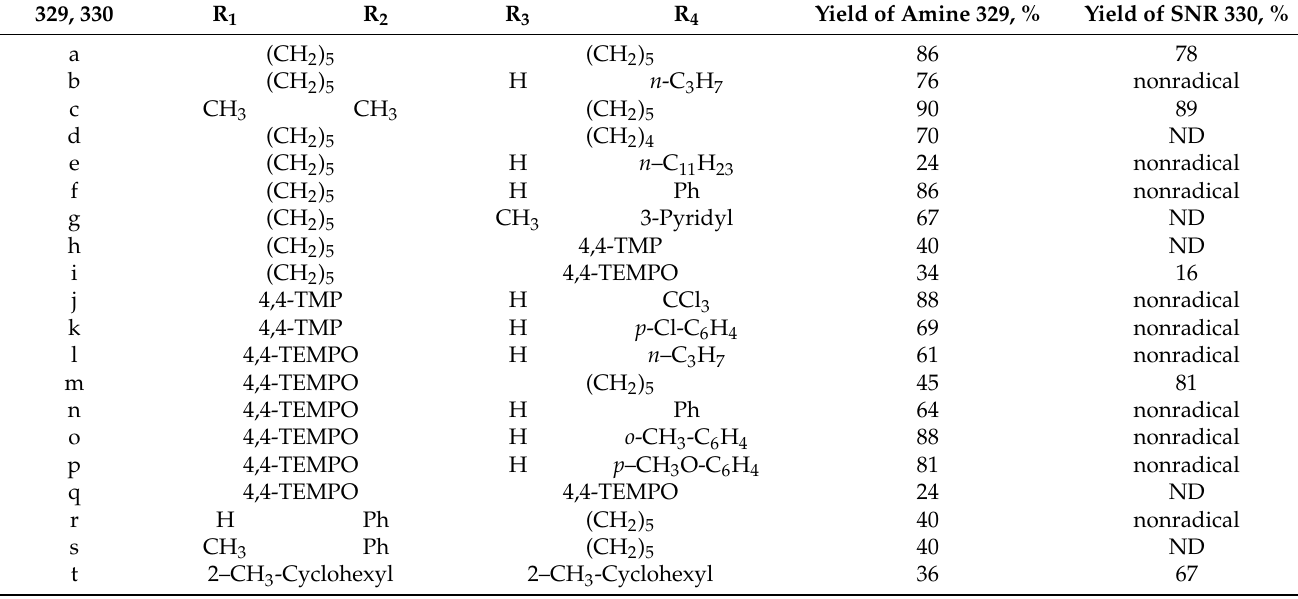
Table 2. The set of spirocyclic amines 329a–t and SNRs of the imidazolidinone type 330a–t obtained in reference